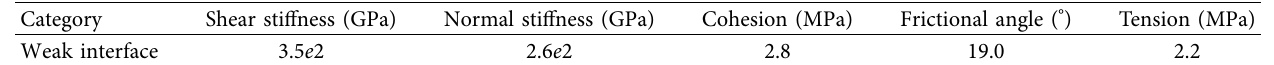
Table 2: The parameters of the